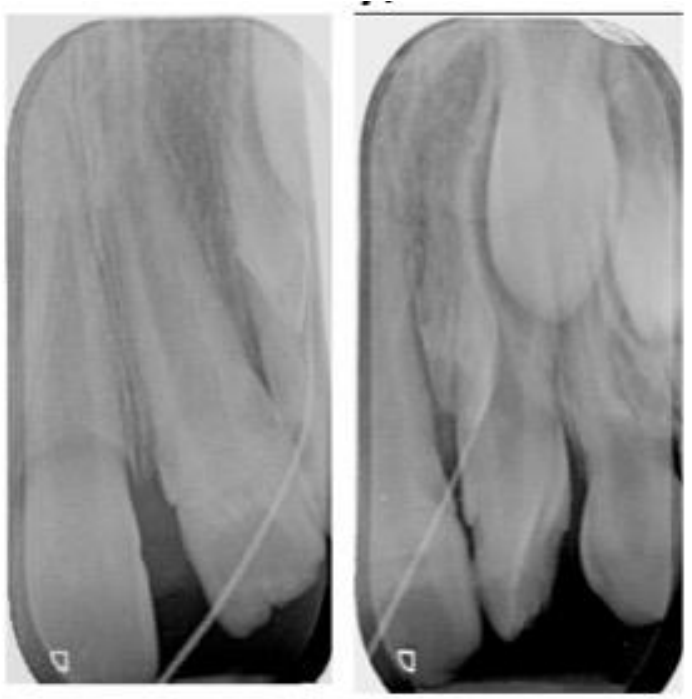
Figure 2. Periapical radiographs at initial assessment taken at different angles to locate the “extra tooth” with a Gutta-Percha point to trace the sinus tract.